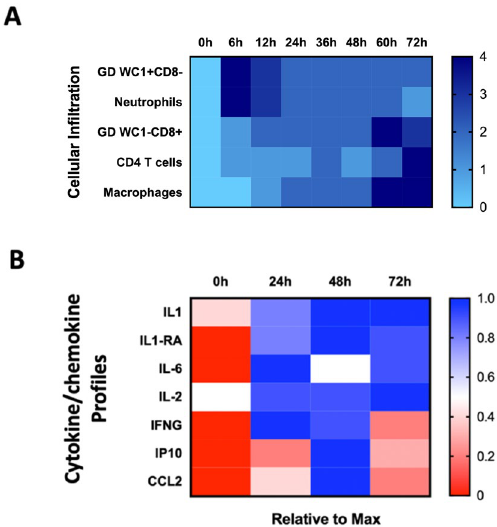
Figure 4. Schematic representation of the kinetics of cellular accumulation ( A ) and cytokine/chemokine profiles ( B ) in bovine tuberculin skin test reaction. ( A ) Cellular compost profiles according to Doherty et al 7 . Cell subset accumulation was scored from 0 to 4 (maximum response) and is expressed as heat map. ( B ) Biomarker profiles established in the present study are expressed as heat-map based on the maximum expression (100%) of each chemokine and cytokine